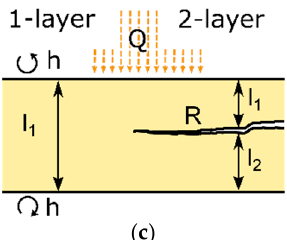
Figure 1. ( a ) Four flashes were used in the set-up in reflection geometry. ( b ) GFRP specimen depicted from the side, the delamination starts right at the edge of the notch. ( c ) Parameters used for the one and two-layer quadrupole model, beside the material